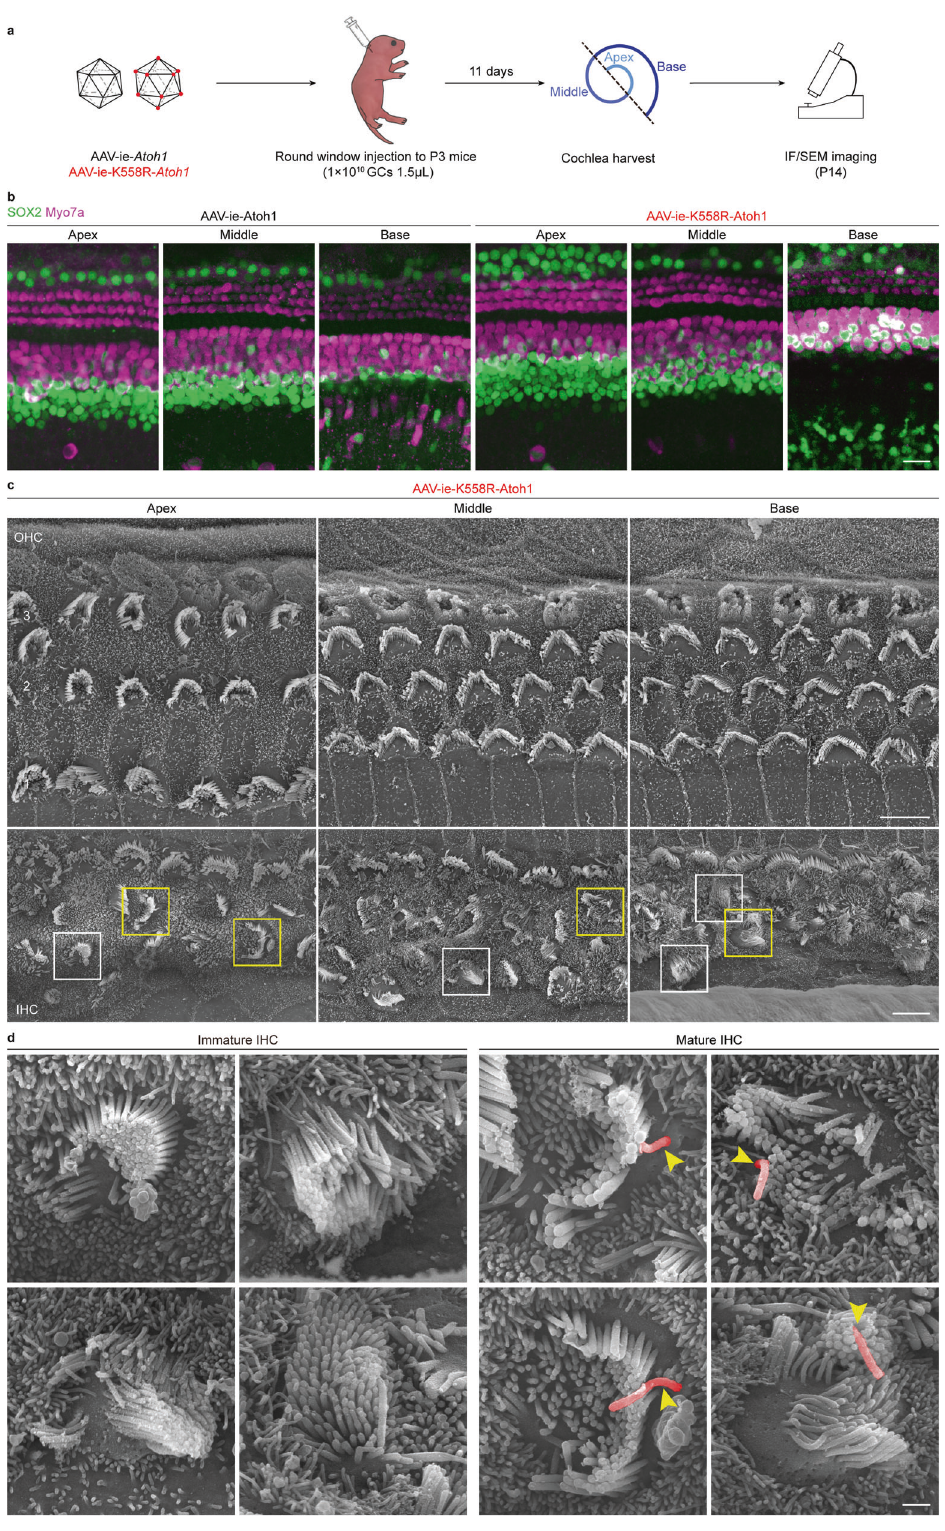
Fig. 4 AAV-ie-K558R- Atoh1 can regenerate HC-like cells in neonatal mice. a Schematic of AAV-induced hair cell regeneration in WT C57BL/6 neonatal mice. b Immuno fl uorescence imaging of cochlea transduced with AAV-ie- Atoh1 and AAV-ie-K558R- Atoh1 at dose of 1 × 10 10 GCs. Scale bar: 20 μ m. c SEM images of a cochlea injected with AAV-ie-K558R- Atoh1 on P14 in the apical, middle and basal regions. Top row, three rows of OHCs are numbered. Bottom row, boxes show immature (white) and mature (yellow) HC-like cells regenerated by AAV-ie-K558R- Atoh1 . Scale bar: 5 μ m. d Magni fi ed SEM images of the immature and mature regenerated HC-like cells shown in c as numbered. Stereocilium were observed in these regenerated cells, and kinocilium was arti fi cially colored as red. Immature regenerative cells did not show kinocilia and obvious polarity, whereas those regenerative cells that grew kinocilium (yellow arrowhead) with certain polarity were considered more mature. Scale bar: 1 μ